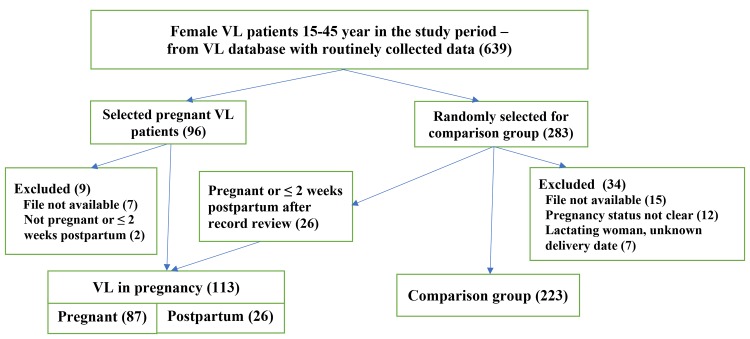
Study flow diagram.